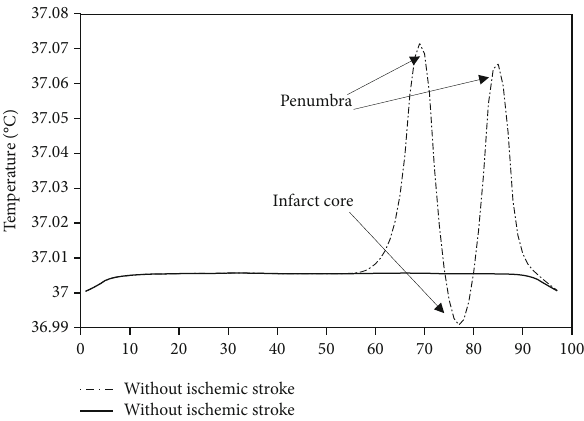
Figure 4: One-dimensional representation of temperature pro fi le on the path passes through the center of the acute ischemic stroke lesion. The temperature is reduced in infarct core compared to normal tissue. However, the temperature is warmer in penumbra compared to normal brain